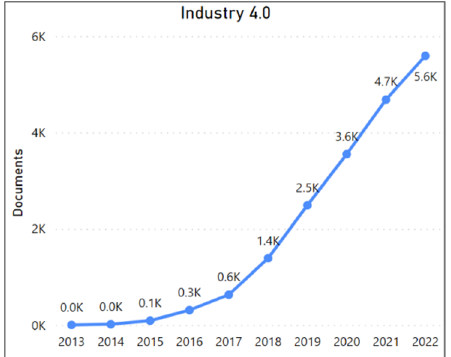
Figure 5. Industry 4.0—years 2006–2022. No data before 2012, 18,760 documents in period.